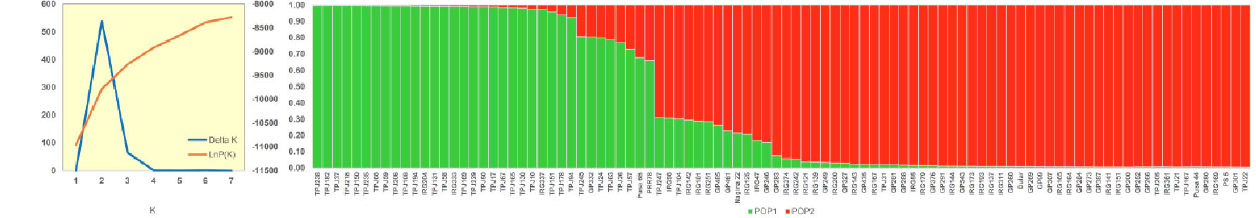
Figure 4. The maximum Δ k estimate indicates the presence of two subpopulations among the wide compatible varieties.